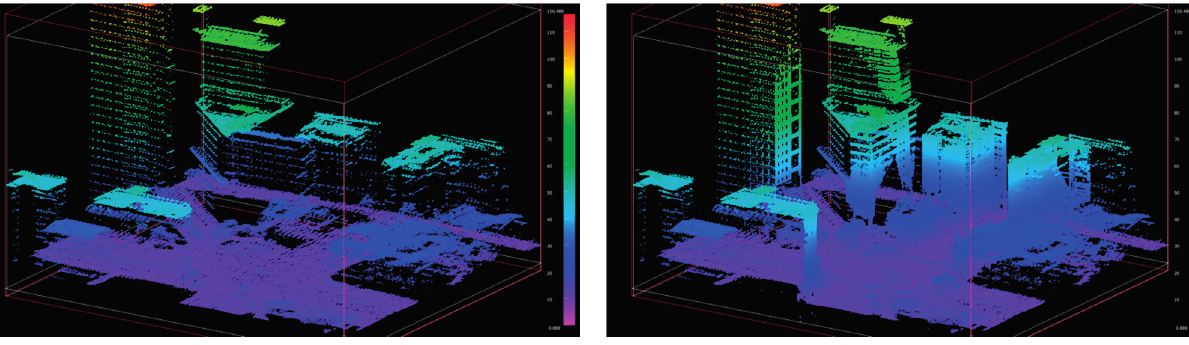
Figure 15. The results of ALS and MLS registration: ( a ) ALS only (colored by height), ( b ) registration of ALS and MLS (colored by